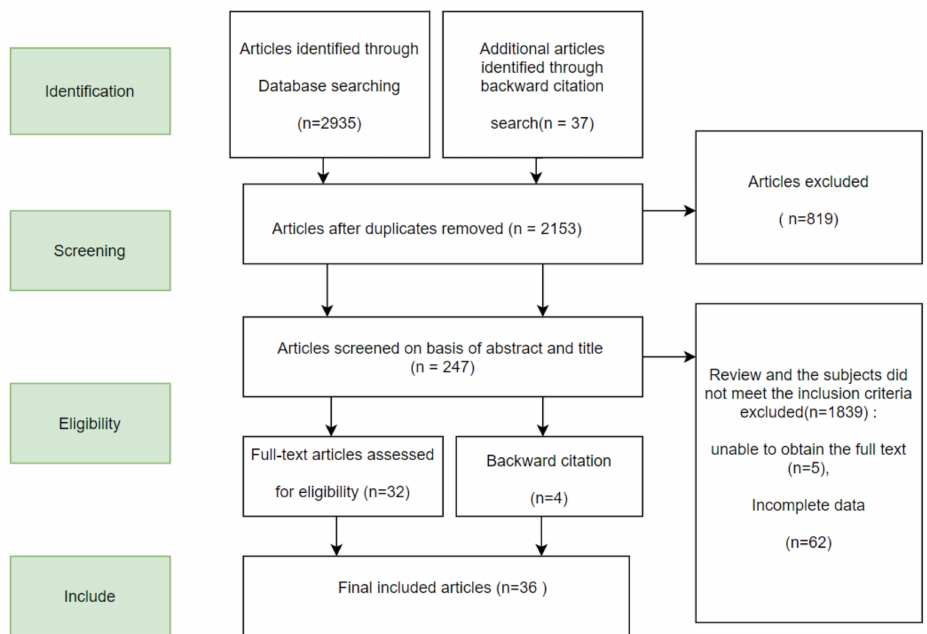
Figure 1. Flow chart of literature